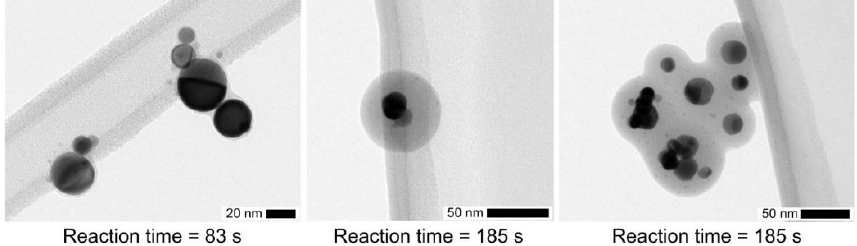
Figure 7. TEM micrographs showing the time dependence of the coating thickness for a constant TEOS concentration of 0.7 ppmv.